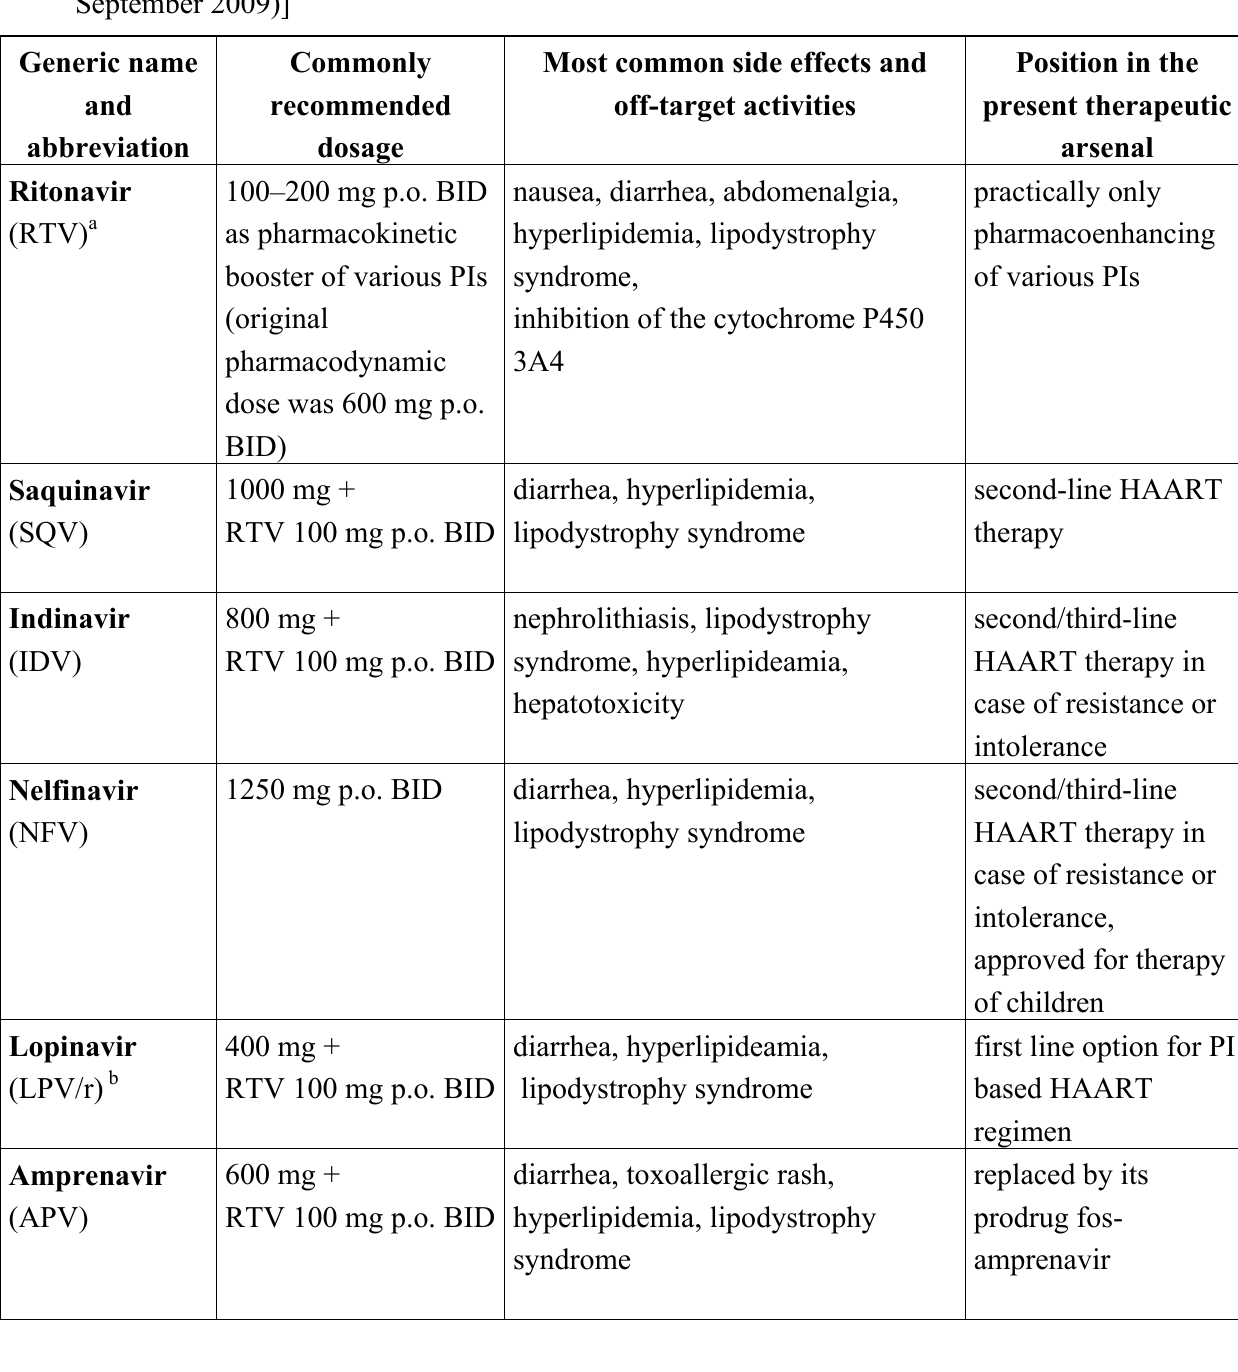
Table 2. Overview of the inhibitors of HIV protease approved for clinical use with their dosage, side effects, and the position in the present therapeutic arsenal, elaborated with regard to the recommendations of the US Department of Health and Human Services [Panel on Antiretroviral Guidelines for Adults and Adolescents. Guidelines for the use of antiretroviral agents in HIV-1-Infected adults and adolescents. Department of Health and Human